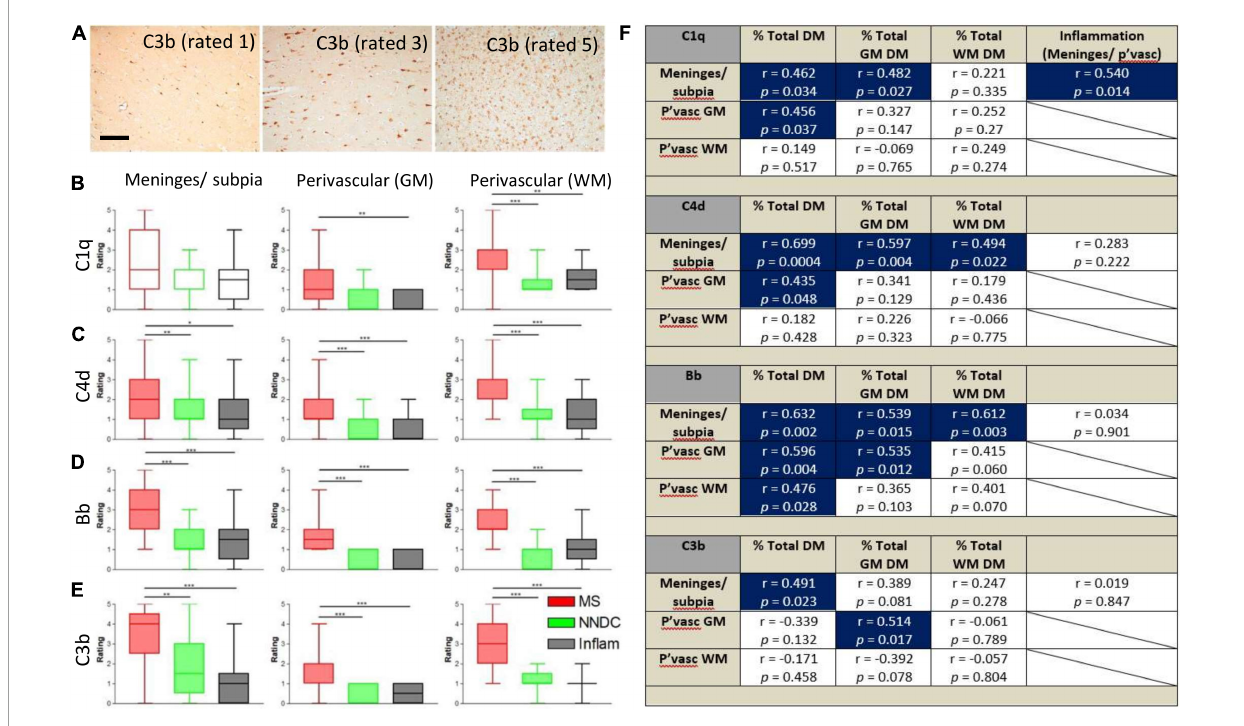
FIGURE2 Semi-quantitative assessment of complement immunoreactivity in the progressive MS neocortex. Examples of complement C3b immunostaining rated as mild (1/5), modest (3/5), and substantial (5/5; A ). Region-matched cortical tissue blocks from 22 progressive MS, 10 non-neurological controls (green bars) and 6 inflammatory disease controls (grey bars) were assessed for complement C1q, C4d, Bb, and C3b immunoreactivity at the meninges/subpial (left column) and perivascular sites of the grey (GM, centre column) and white mater (WM, right column of graphs; B–E ). The relative abundance of C1q in the meninges/subpial correlated with the extent of underlying cortical demyelination and leptomeningeal inflammation; F ), whilst expression of complement activation products C4d and Bb associated with the extent of GM demyelination (% total GM DM), and Bb abd C3b at and adjacent to vessels of the GM (P’vasc GM) correlated with the extent of GM demyelination ( F ; Blue areas indicate correlations with significant results). Group medians were compared with Kruskal–Wallis and Dunn’s multiple comparisons post-test and minimum and maximum values displayed. The extent of complement immunoreactivity was compared to GM pathology by Spearman correlation and r -values and p -values are shown for all comparisons. Pvasc, perivascular sites; % total DM, percent demyelination of the block, % total GM or WM, percent demyelination of the white or grey matter. Scale bar = 100 µ